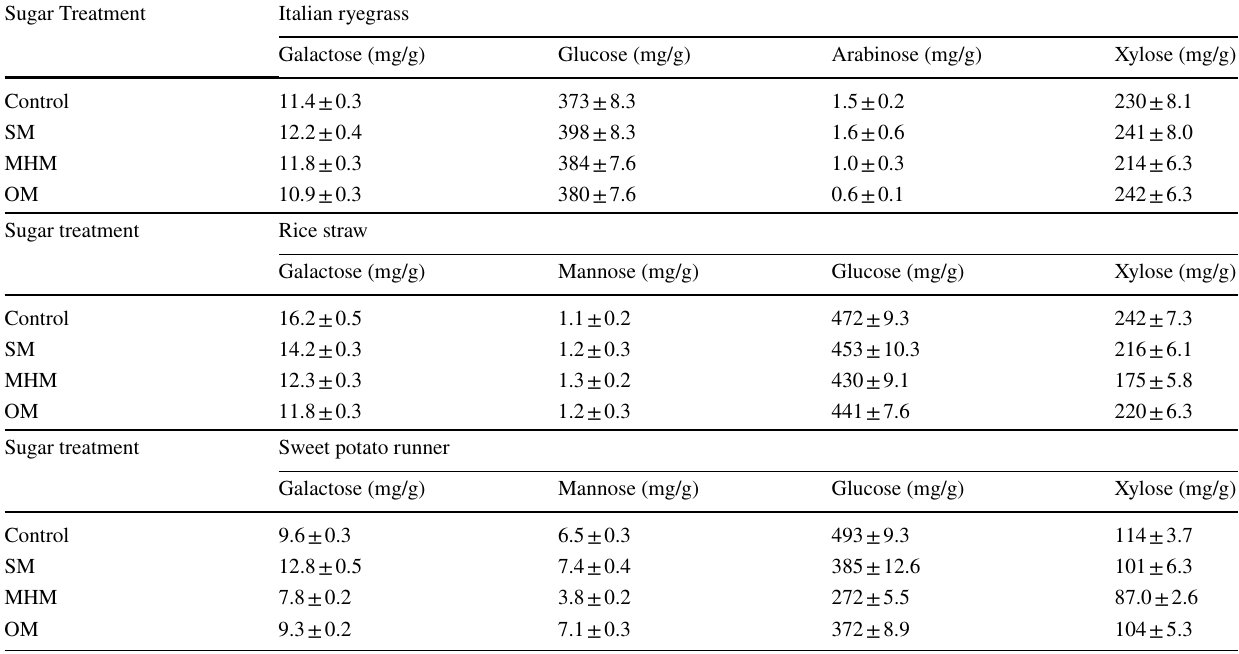
Table 3 Changes in NDF sugar composition after enzyme treatment from mushroom waste Sugar